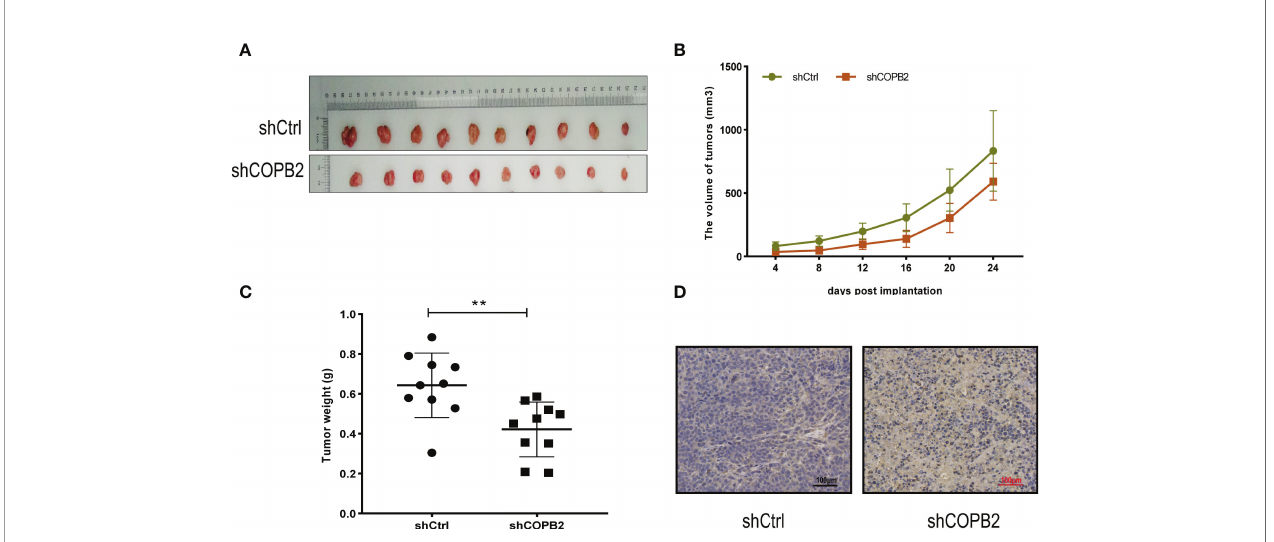
FIGURE 4 | COPB2 knockdown inhibited tumor growth in Nude mice. (A) Tumors grew in Nude mice were removed at day 24 after xenograft. (B, C) Knockdown of COPB2 inhibited tumor growth of xenograpted PC-3 cells based on two-dimensional caliper measurements of volume and weight of tumors, respectively. (D) Representative immunostaining images (original magni fi cation, ×100). ** P < 0.01.